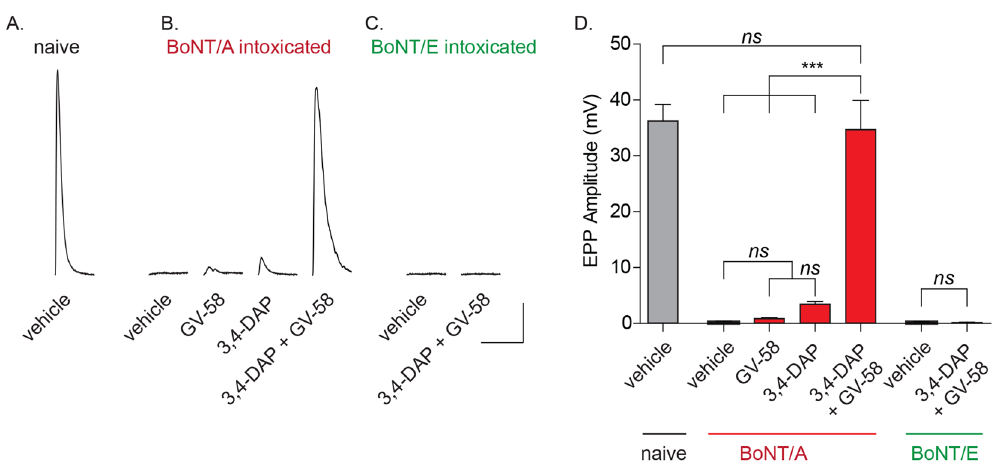
Figure 6. 3,4-DAP plus GV-58 has superadditive effects in restoring robust EPP production in mouse diaphragm endplates fully intoxicated by BoNT/A. Representative evoked endplate recordings (top) and corresponding mean EPP amplitudes (in mV, bottom) from non-intoxicated and BoNT/A-intoxicated mouse phrenic nerve-hemidiaphragm preparations treated with vehicle, GV-58 (50 µ M), 3,4-DAP (2 µ M), or GV-58 plus 3,4-DAP (50 µ M and 2 µ M, respectively); and BoNT/E-intoxicated tissue treated with vehicle, or GV-58 plus 3,4-DAP. Representative traces are the average of six EPPs elicited from single endplates. Scale bars represent 25 ms (x-axis) and 5 mV (y-axis). Grouped data is presented as mean ± SEM (n = 4–6 diaphragm per condition; 5 endplates recorded per diaphragm). *** Indicates p < 0.001, ns = not